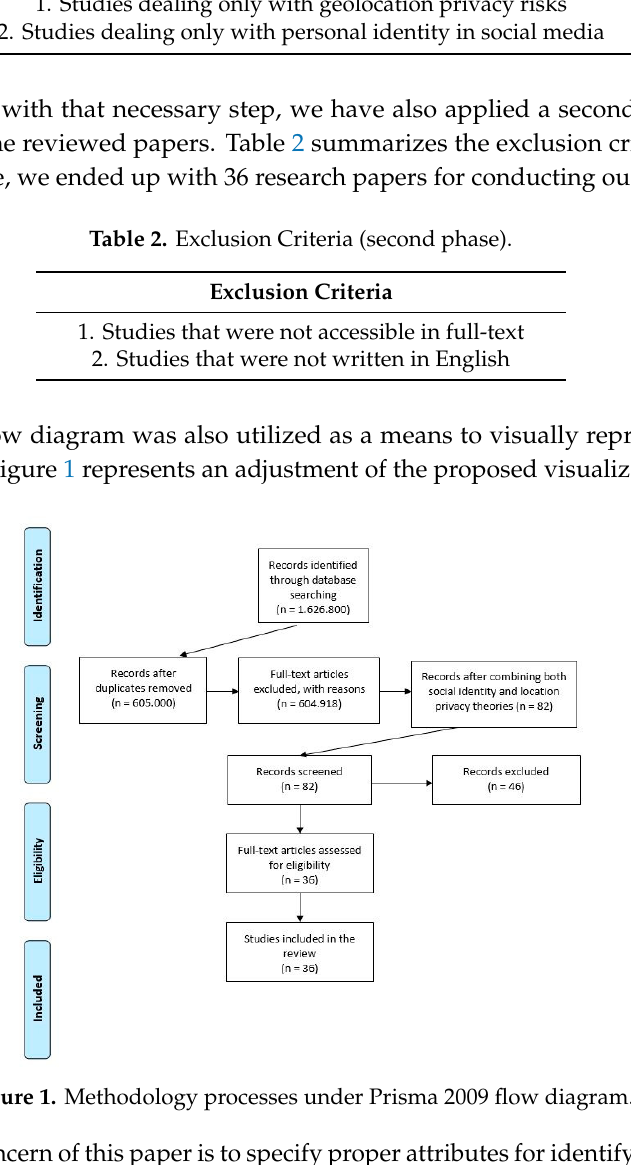
Table 1. Exclusion Criteria (first phase).